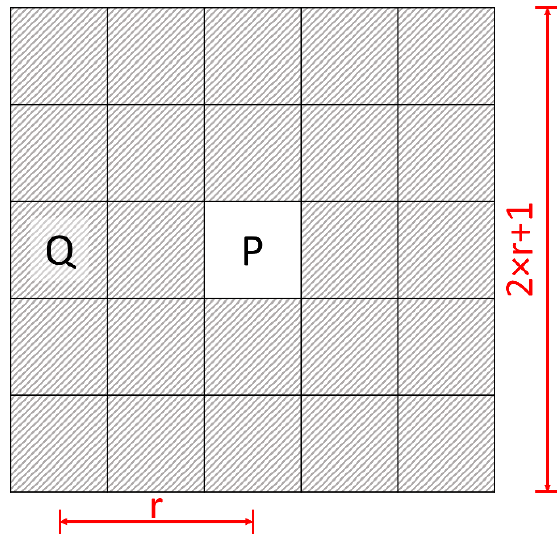
Figure 1. Schematic diagram of the neighborhood of point P. Neighborhood U is marked with stripes. Point Q is in the neighborhood U of P. The weights are calculated within a window of radius r.